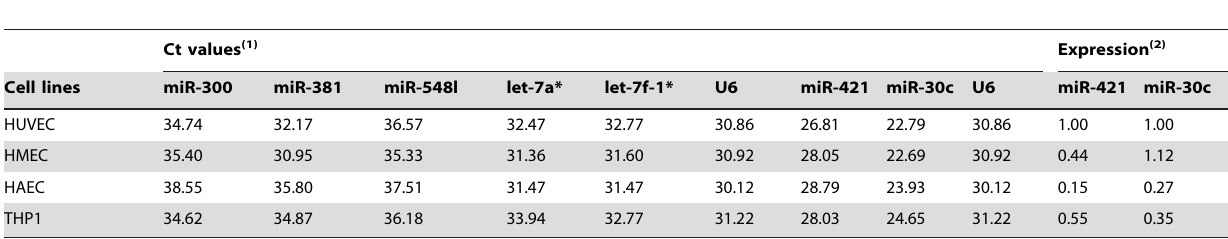
Table 2. Detection of miRNAs of interest by qRT-PCR in various cell lines.